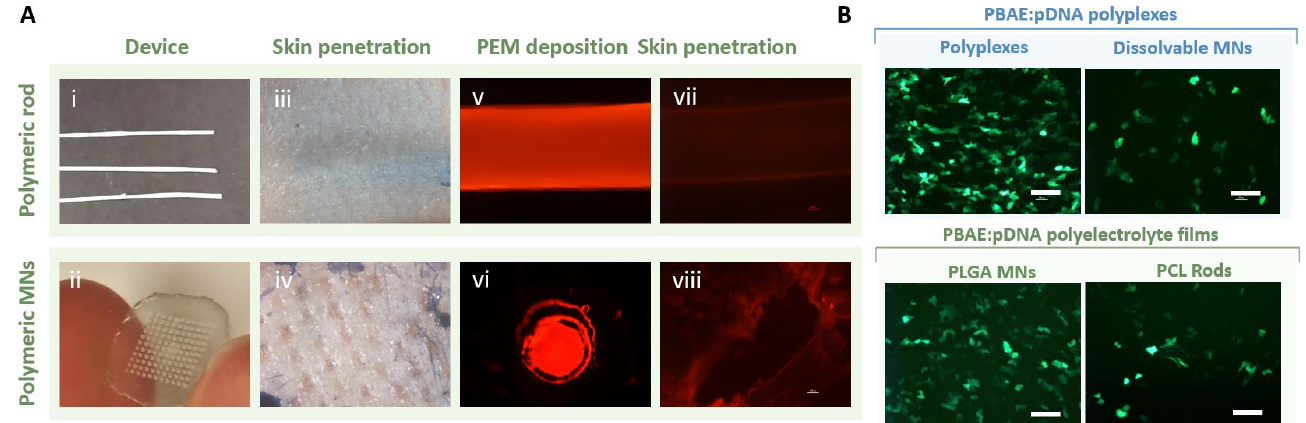
Figure 6. Ex vivo characterization of medical devices for prospective vaccine delivery using PBAE polyelectrolyte films. Capacity of transdermal devices to effectively penetrate the skin was tested using cadaveric skin explants from C57BL/6 healthy mice along with film deposition from rods ( top panel ) or solid PLGA-based MNs ( bottom panel ) ( A ). Fluorescence microscopy following transfection with the K/D and K/D-Man polymers as PBAE:pDNA polyplexes ( top ) and PBAE:pDNA films ( bottom ) in HaCaT cells ( B ). Scale bar = 50 µm.